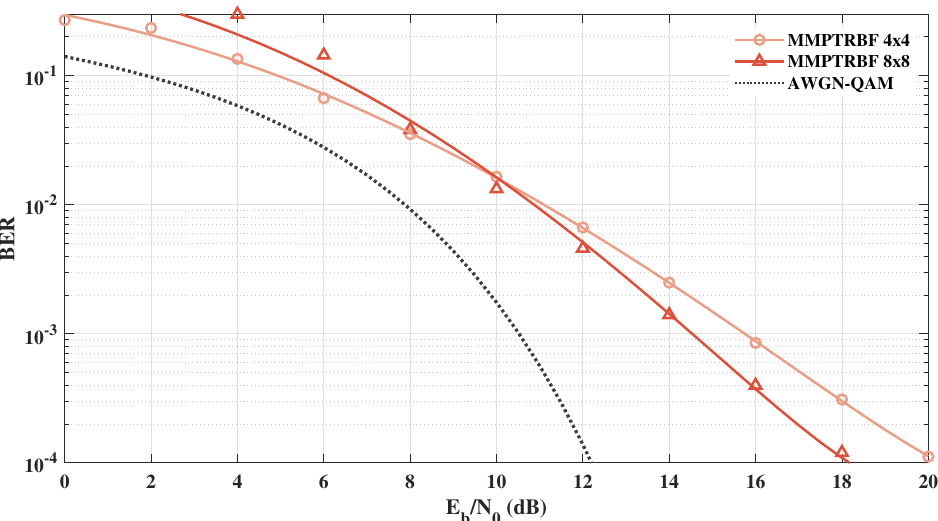
Figure 22. MMPTRBF with M T = M R = 4 and M T = M R = 8 antennas operating at the same bitrate with 16-QAM modulation.